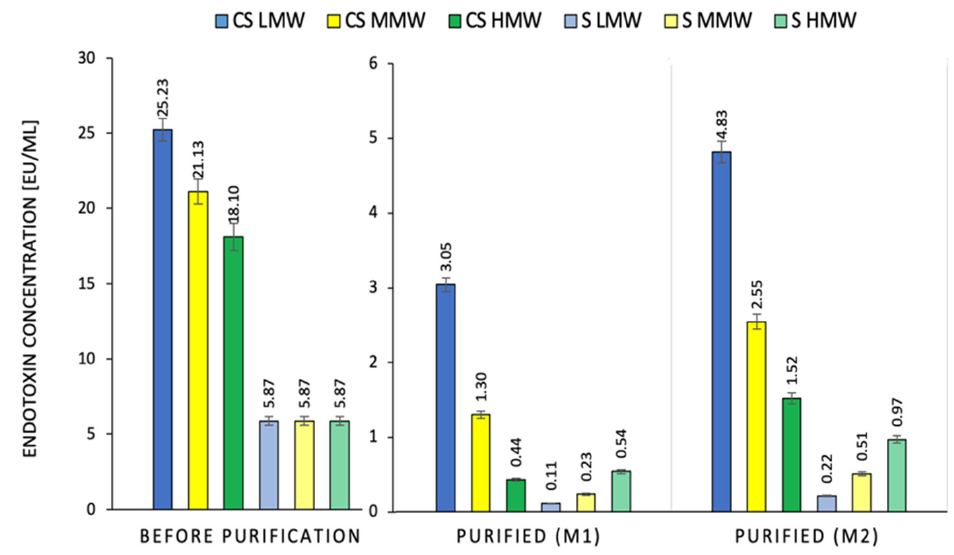
Figure 1. Comparison of endotoxin concentration in CS hydrogels: low molecular weight (LMW), medium molecular weight (MMW), and high molecular weight (HMW) and standard endotoxin solutions (S) after contact with CS of different molecular weights, before and after purification using M1 or M2 method ( n = 3, p < 0.05).